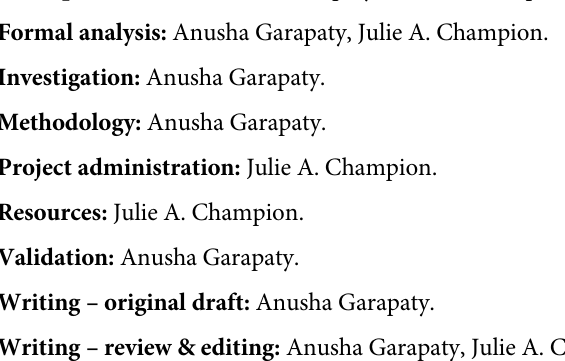
S1 Table. Area under the curve (AUC) calculations for particle fluorescence flow cytome- try curves in Fig 1 based on trapezoidal rule. Listed is the ratio of rod AUC (red curves in Fig 1) and sphere AUC (blue curves in Fig 1). S1 Fig. Fluorescent rod shaped polystyrene particles (scale bars 10 μ m). (TIFF) S2 Fig. Fluorescent spherical polystyrene particles (scale bars 10 μ m).